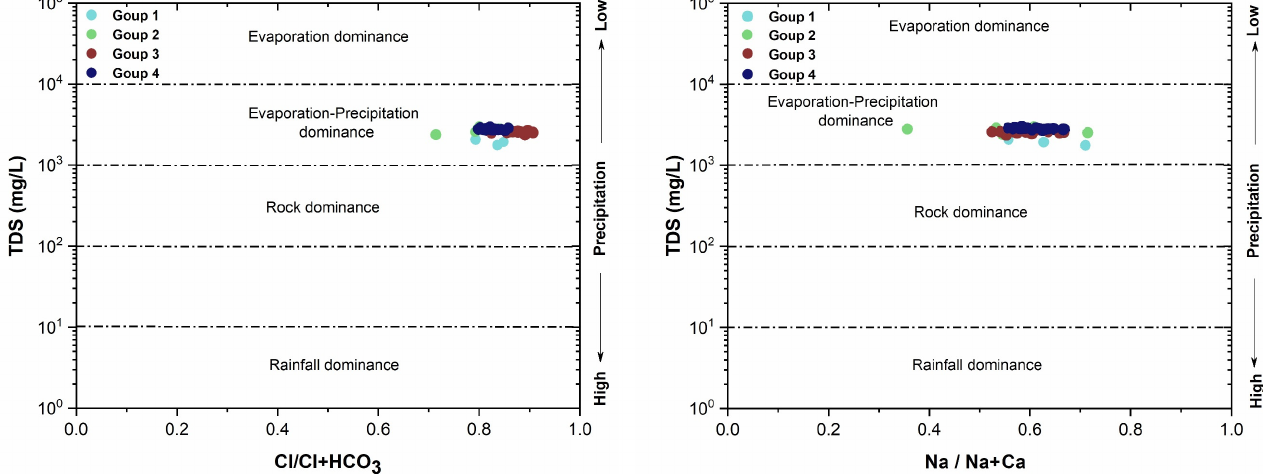
Figure 12. Gibbs diagrams of the complex terminal groundwater aquifer.